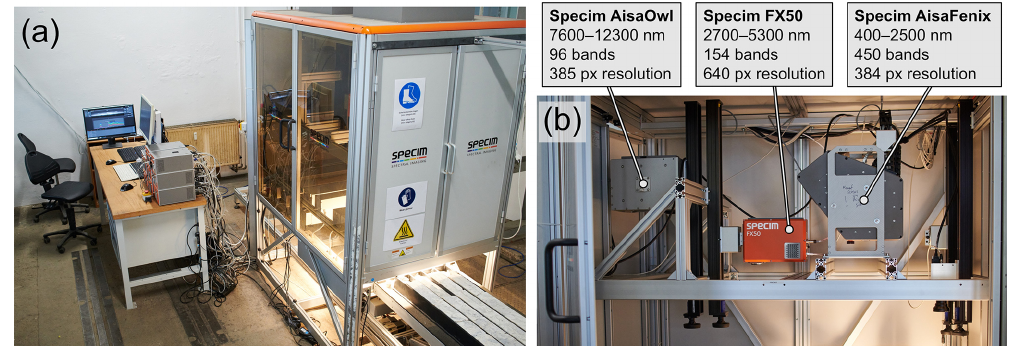
Figure 4. (a) Specim SisuROCK hyperspectral drill core scanner with (b) mounted sensors in the visible to near-infrared and shortwave infrared (VNIR and SWIR), mid-wave infrared (MWIR), and longwave infrared (LWIR) range.